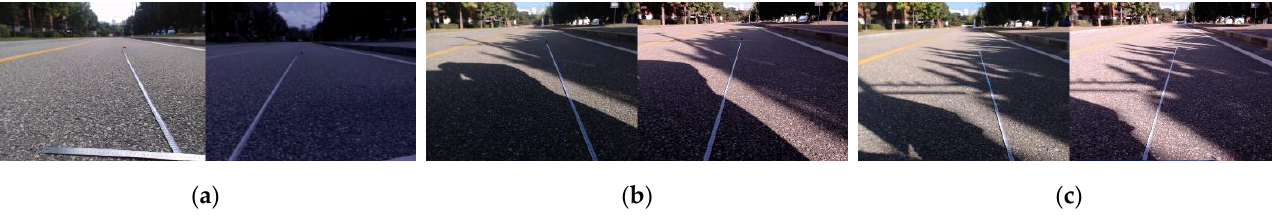
Figure 6. Input images corresponding to different heights: ( a ) corresponding to a height of 30 cm, ( b ) corresponding to a height of 40 cm, and ( c ) corresponding to a height of 50 cm.